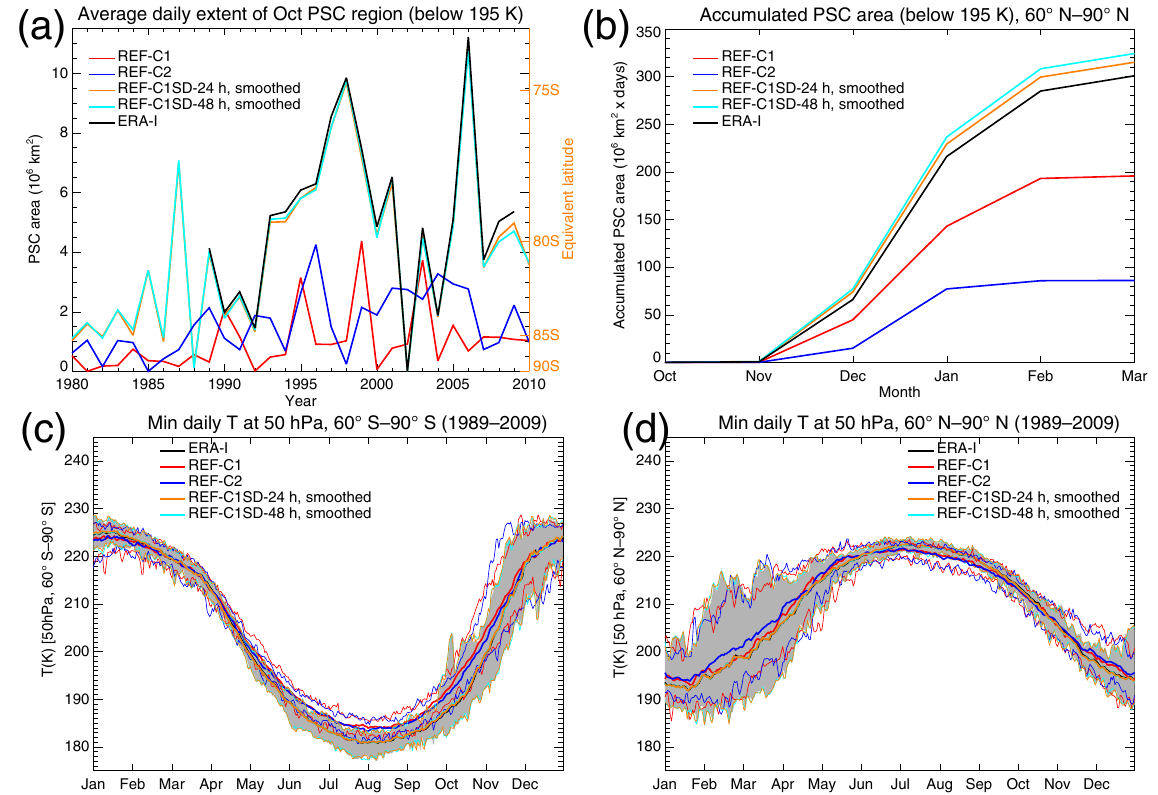
Figure 6. (a) Average daily October nitric acid trihydrate (NAT) PSC area, at 50hPa, in the Southern Hemisphere, defined as the area poleward of 60 ◦ S with daily mean temperatures below 195K. (b) Accumulated daily PSC area, at 50hPa, in the Northern Hemisphere, defined as the area poleward of 60 ◦ N with daily mean temperature below 195K. (c) Minimum 50hPa daily mean temperature in the region 60–90 ◦ S. (d) Minimum 50hPa daily mean temperature in the region 60–90 ◦ N. Thick and thin lines, and shading, in panels (c) and (d) are as in Fig. 4. All panels are averaged over the years 1989–2009. Note that the temperature is used as a proxy for PSC area here, and thus these are estimates of the PSC area seen by the interactive chemistry.